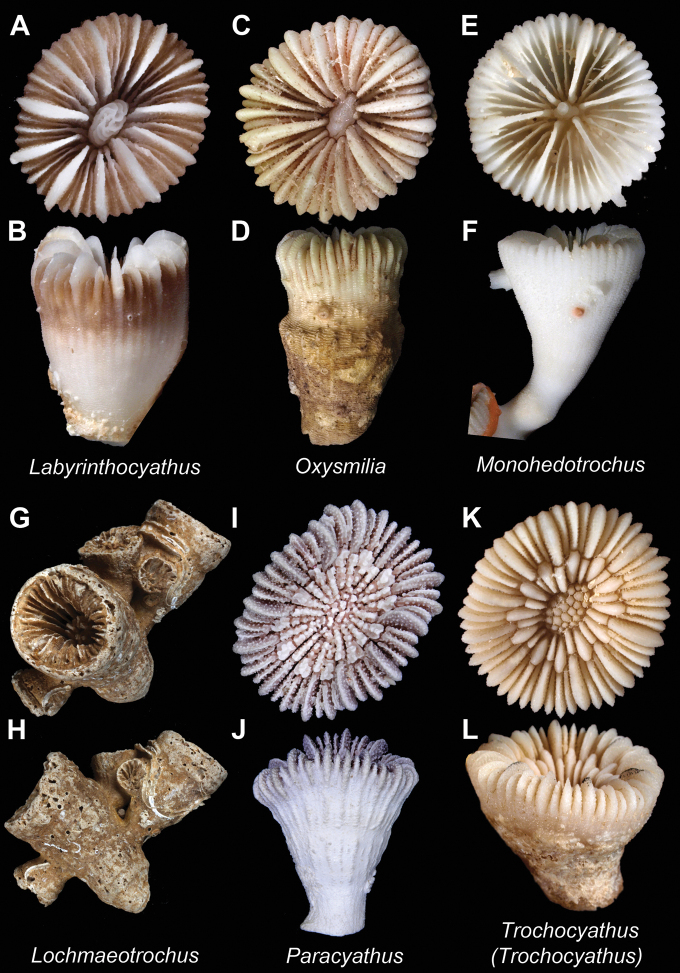
Labyrinthocyathus limatulus (USNM uncatalogued, Bathus 4 stn. DW 936)A and B Calicular and lateral view respectively; Oxysmilia corrugata (USNM uncatalogued, Norfolk 2 stn. DW2125)C and D Calicular and lateral view respectively; Monohedotrochus circularis (USNM uncatalogued, Norfolk 2 stn. DW2124)E and F Calicular and lateral view respectively; Lochmaeotrochus oculeus(USNM uncatalogued, Musorstom 6 stn. DW394)G and H Calicular and “aggregation” view respectively; Paracyathus sp. (MNHN uncatalogued, Ebisco stn. DW2555) I and J Calicular and lateral view respectively; Trochocyathus efateensis (USNM uncatalogued, Bathus 4 stn. DW818) K and L Calicular and lateral view respectively. Scale bars represent 5 mm. Bold face indicates type species for the genus.